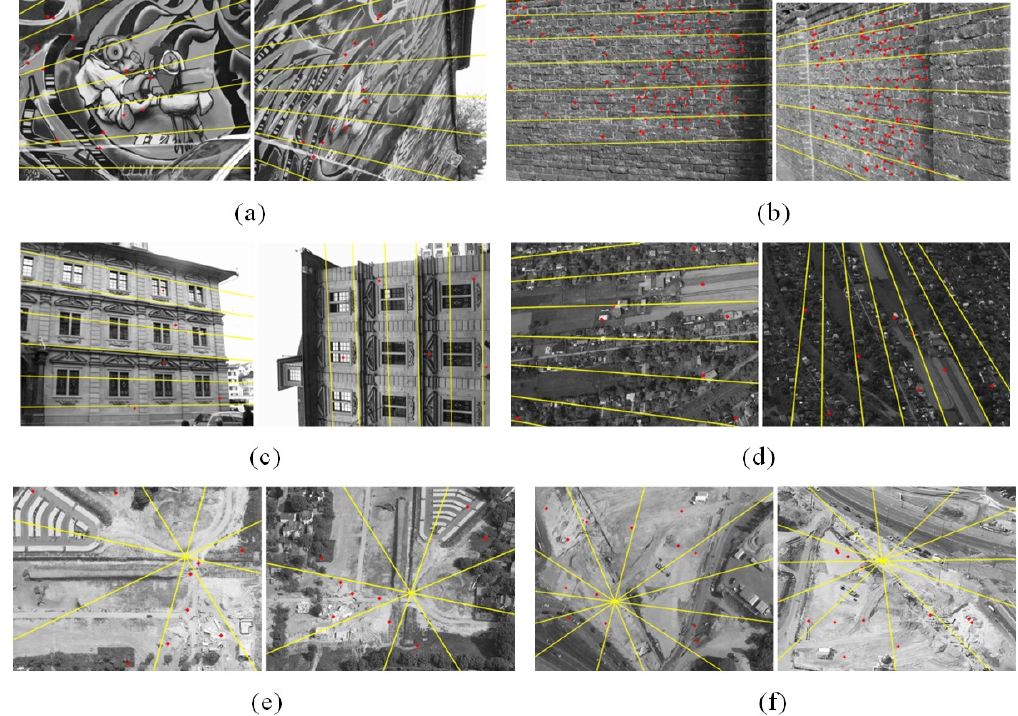
Figure 10. ( a )–( f ) Red points show the matching results of the Detone’s method with groups of stereo images. The yellow lines represent the epipolar lines estimated from matching points.